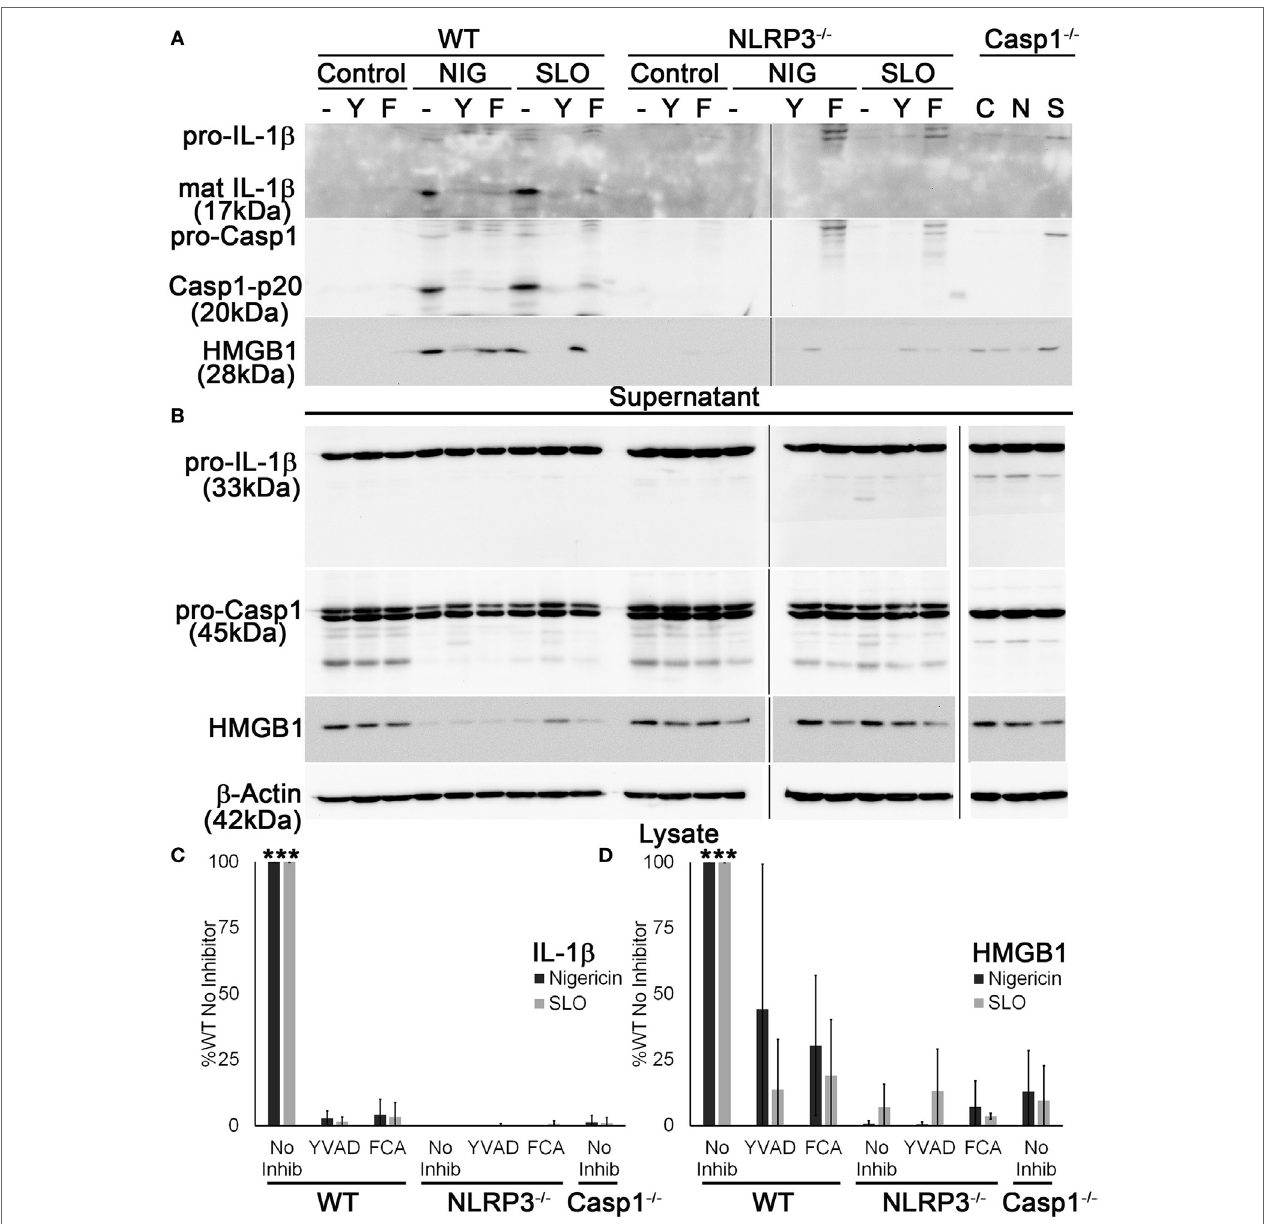
FigUre 4 | Dnase1l3 activity is required for caspase-1 (casp1) activation . Lipopolysaccharide-primed BMDM from wild-type (WT), Casp1 − / − , or NLRP3 − / − mice were treated without ( − ) or with 100 µM YVAD (Y) or 100 µM fmoc- d -cyclohexylalanine (FCA) (F) for 30 min followed by nothing (C), 20 µM nigericin (N or NIG), or 0.5 kHU/mL streptolysin O (SLO) (S) for 30 min. Supernatants (a) were trichloroacetic acid precipitated, and cells (B) were lysed in SDS sample buffer. Proteins were resolved by SDS-PAGE and transferred to nitrocellulose. High-mobility group box 1 protein (HMGB1), Casp1, IL-1 β , and β -actin were detected by western blot. (c) The levels of mature IL-1 β in the supernatant were ratioed to pro-IL-1 β levels in the cell lysates, or (D) levels of secreted HMGB1 were ratioed to HMGB1 in the lysate, and all expressed as a percentage of B6 BMDM treated with no inhibitor. Immunoblots are representative of four independent experiments, while graphs show mean ± SEM of four independent experiments. *** p < 0.001 compared to inhibitors and knockouts (except compared to WT YVAD for HMGB1, which was not